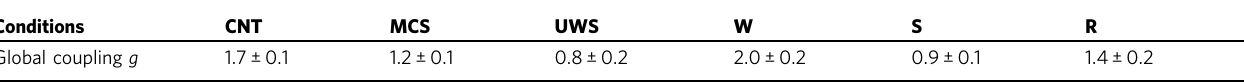
Table 2 Estimated global coupling parameters (means and standard deviations) for all experimental conditions. Conditions